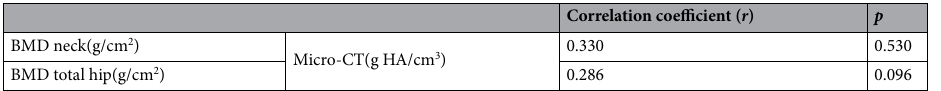
Table 3. Correlation between the BMDs of the contralateral hip and that of the fracture femoral head.